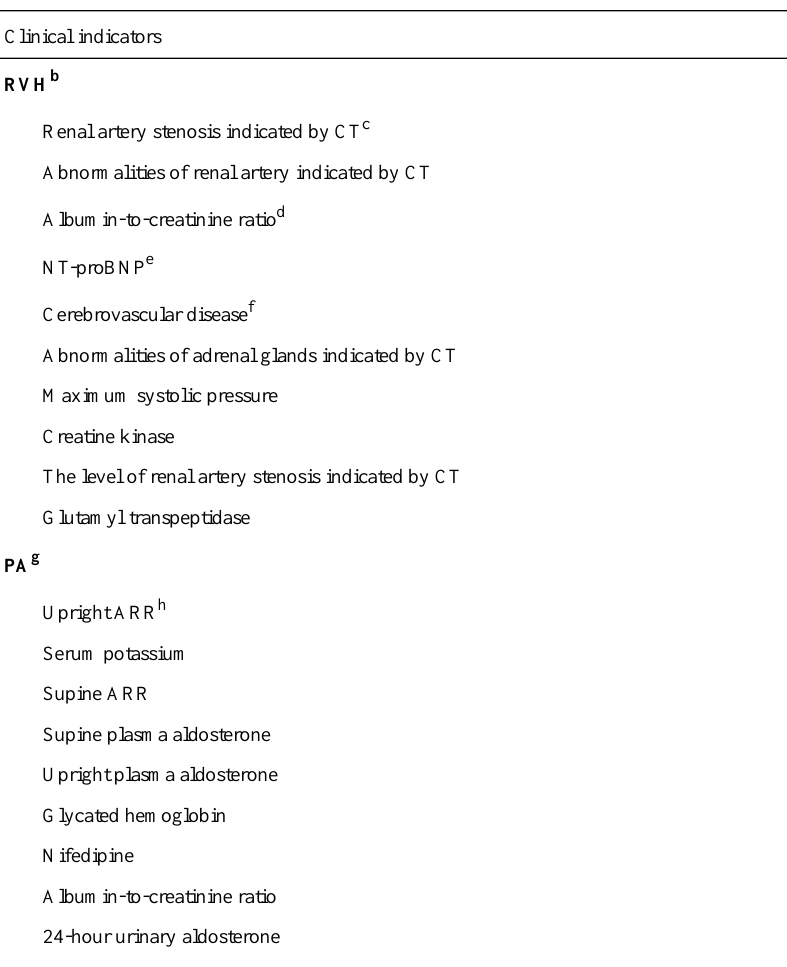
Table 3. Top 10 clinical indicators for prediction